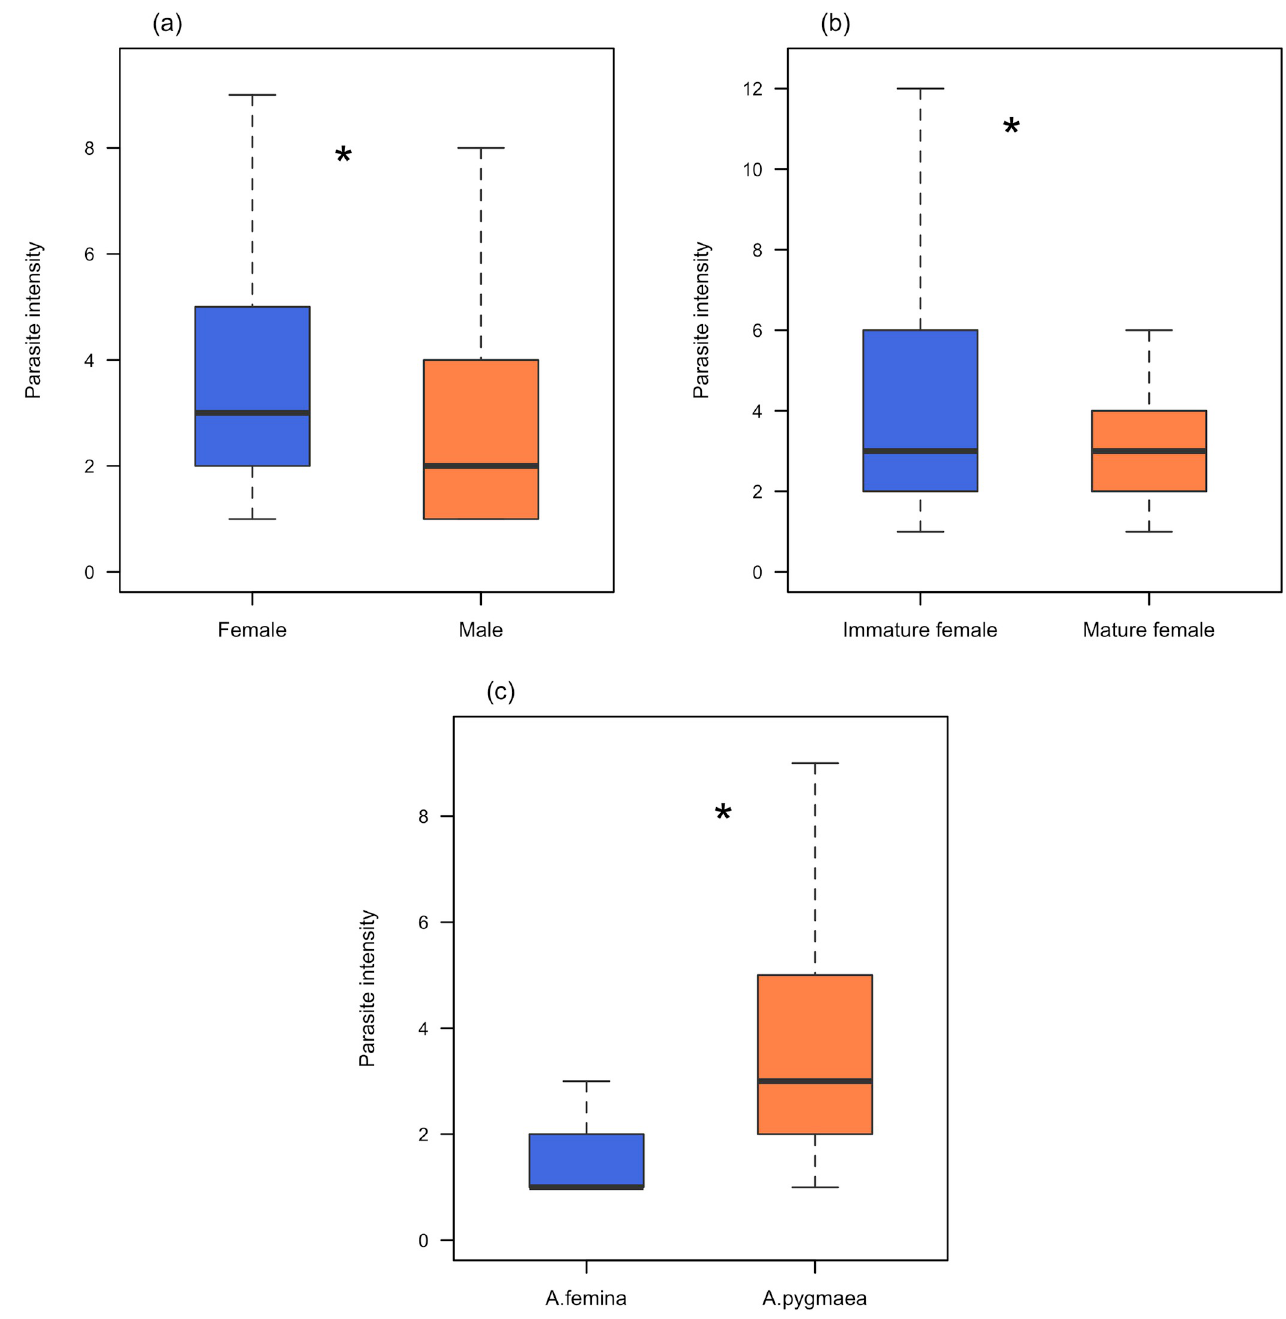
Fig 4. Parasite intensity in females, males, immature and mature females of Agriocnemis femina and Agriocnemis pygmaea respectively. (a) Parasite intensity in females and males. (b) Parasite intensity in immature and mature females. (c) Parasite intensity in Agriocnemis femina and Agriocnemis pygmaea . The boxplots represent the median, 25th and 75th percentiles. The error bars extend downward from the first quartile to the minimum and upward from the third quartile to the maximum data points. Data points beyond the error bars are 1.5 times greater than the interquartile range and excluded. � indicates significant variation (p < 0.001) between studied